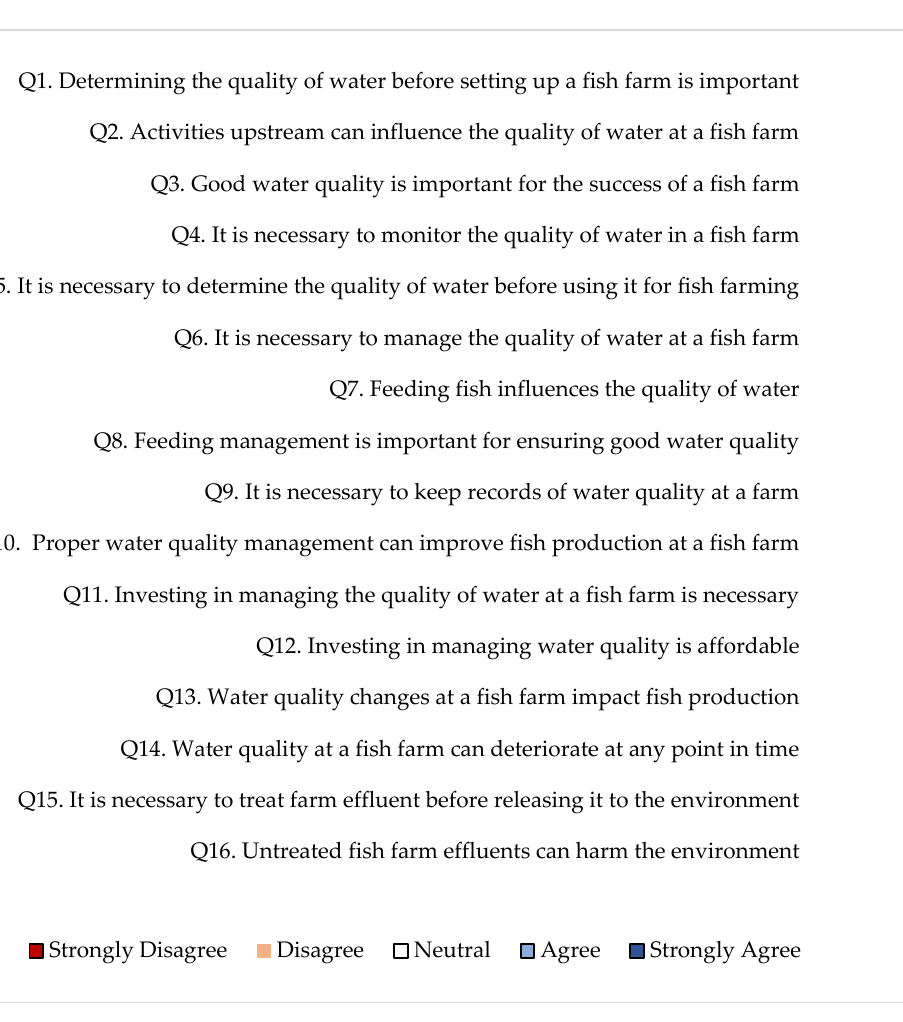
Figure 3. Assessment of the attitudes of fish farmers towards water quality and its management in five districts of the Rwenzori region.